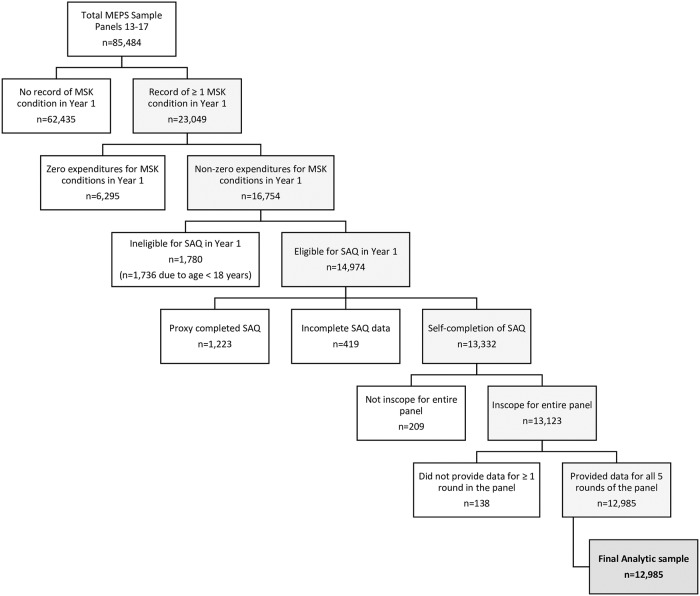
Flow diagram of the selection process for the final analytic sample.